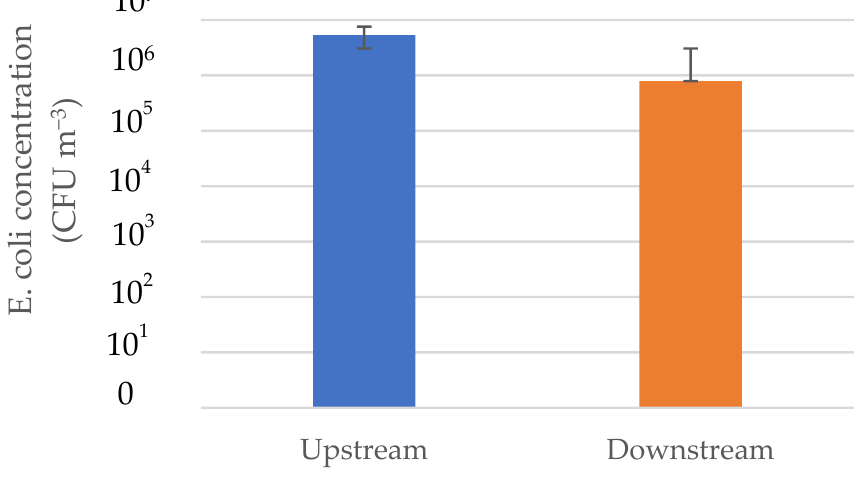
Figure 6. Physical loss of airborne E. coli . Temperatures and RH are shown in Table 2. The temperatures and RH remained stable over the experiments. However, there was a slight decrease in RH at the short contact time (0.23 s). An explanation could be that dehydration affected RH. At a short contact time or high wind speed, the dehydration effect in the air inside of chambers would increase leading to the decrease of RH